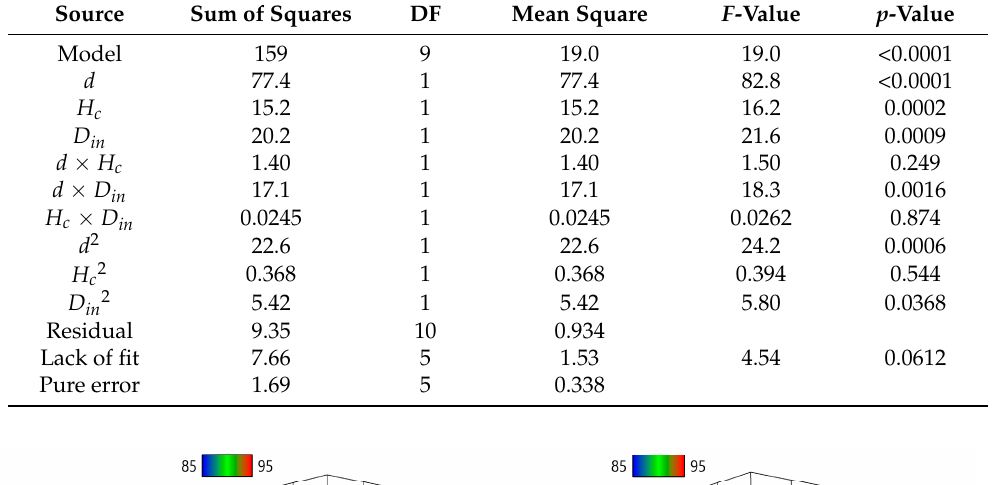
Table 2. ANOVA for Equation (5).